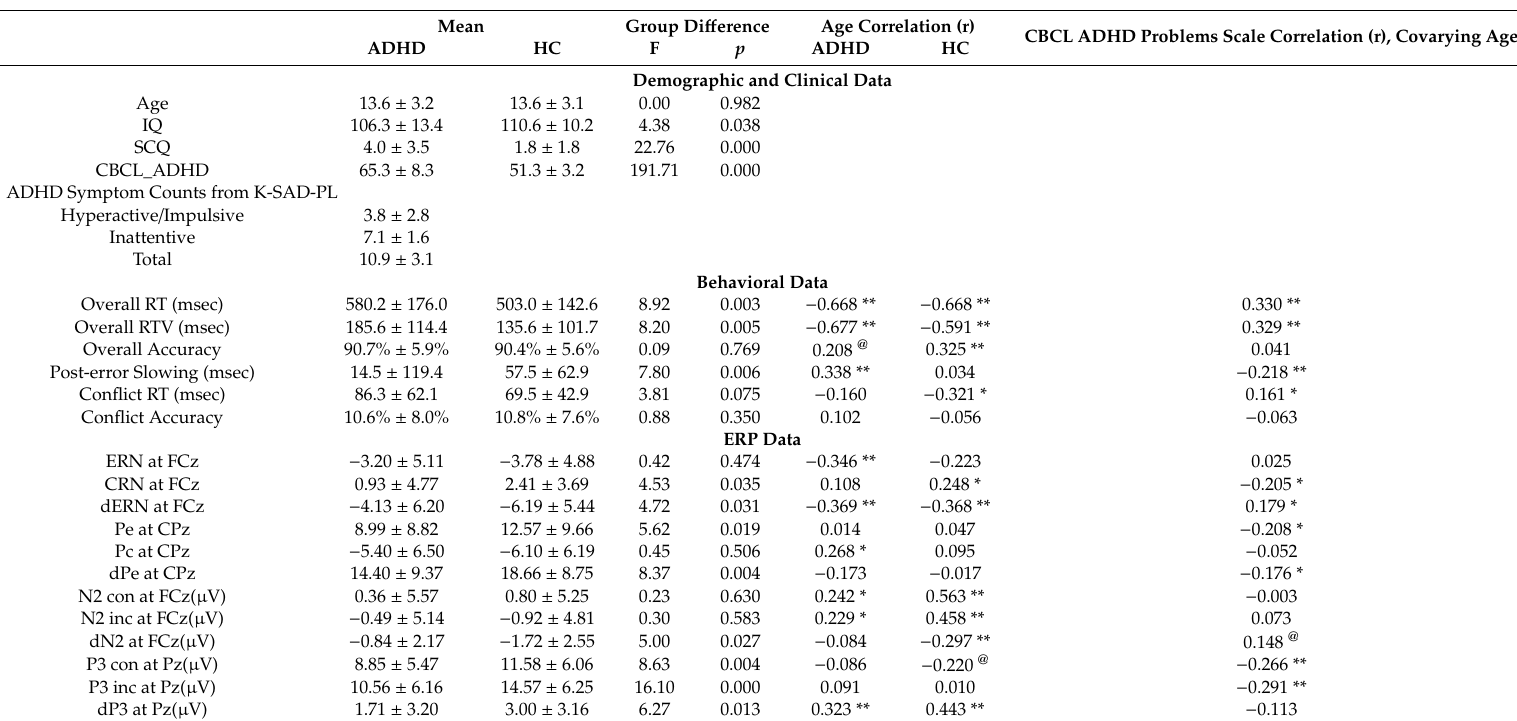
Table 1. Demographic, Behavioral and event-related potential (ERP) measures in participants with attention-deficit / hyperactivity disorder (ADHD) compared to healthy controls